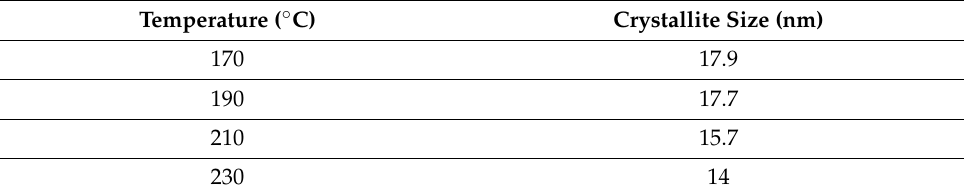
Figure 1. XRD pattern of TiO 2 nanostructures prepared at the different temperatures indicated. The peaks highlighted with stars correspond to those of the substrate. Table 1. Crystallite size of TiO 2 powders prepared at various temperatures.